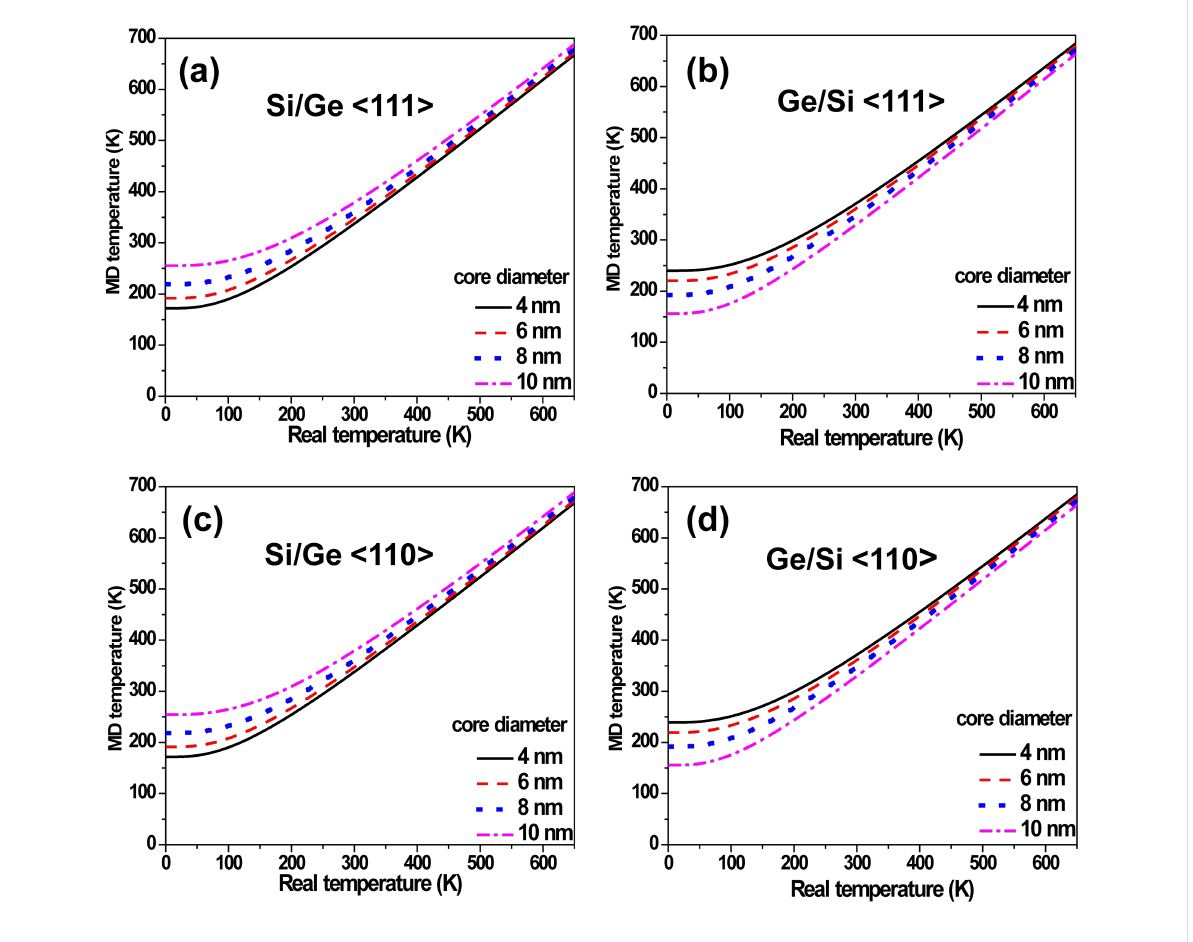
Figure 3: Quantum scaling between the real and classical (MD) temperatures for the (a) Si/Ge <111>, (b) Ge/Si <111>, (c) Si/Ge <110> and (d) Ge/Si <110> CSNWs. The minimum nonzero MD temperature corresponding to 0 K (real temperature) reflects the zero-point vibrations of the atoms.